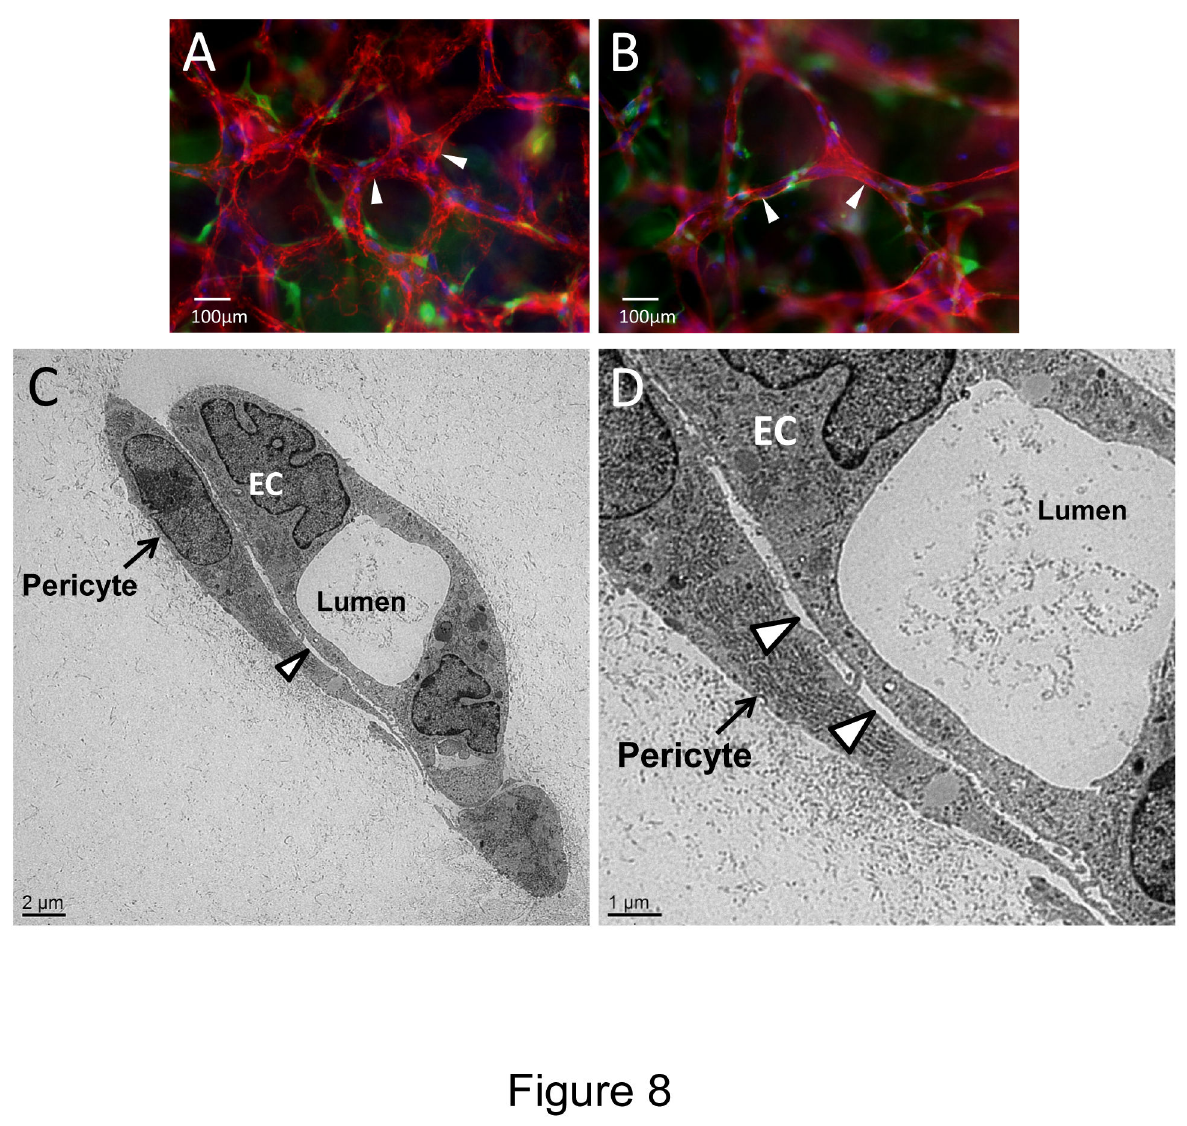
Figure 8. EC-pericyte tube co-assembly in 3D fibrin matrices under defined serum-free conditions leads to vascular basement membrane matrix formation. ECs that were primed with VEGF/FGF-2 and GFP-pericytes were seeded together into 3D fibrin matrices in the presence of hematopoietic stem cell cytokines and after 120 hr, cultures were fixed for fluorescent immunomicroscopy (A,B), and for transmission electron microscopy (C,D). Cultures were stained with antibodies to collagen type IV (A) and laminin (B) demonstrating vascular basement membrane formation. Arrowheads indicate basement membrane matrix deposition. Bar equals 100 µm. (C,D) Transmission electron micrographs showing pericytes along an EC tube structure with a defined lumen space and vascular basement membrane deposition observed between the two cell types (arrowheads). Arrows indicate pericytes. Bars equal 2 µm (C) or 1 µm (D).